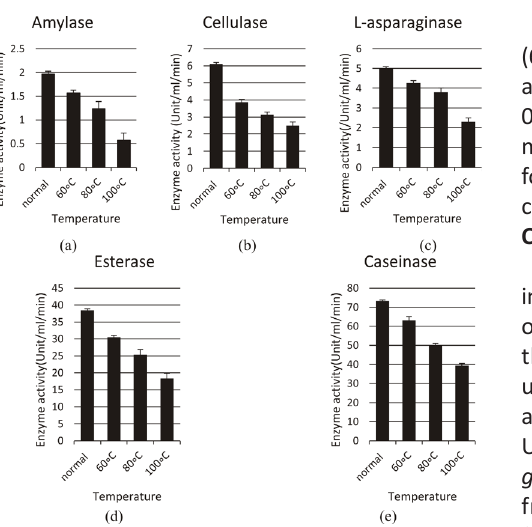
Fig. 4. The stability profile of various enzymes produced from different isolates at various temperatures (normal assay condition, 60°C, 80°C, and 100°C). (a) For amylase ( Streptomyces mutabilis ), (b) For cellulase (Streptomyces ghanaensis) , (c) For L- asparaginase (Enterobacter cloacae) , (d) For esterase (Streptomyces ghanaensis) and (e) For caseinase ( Streptomyces rochei )